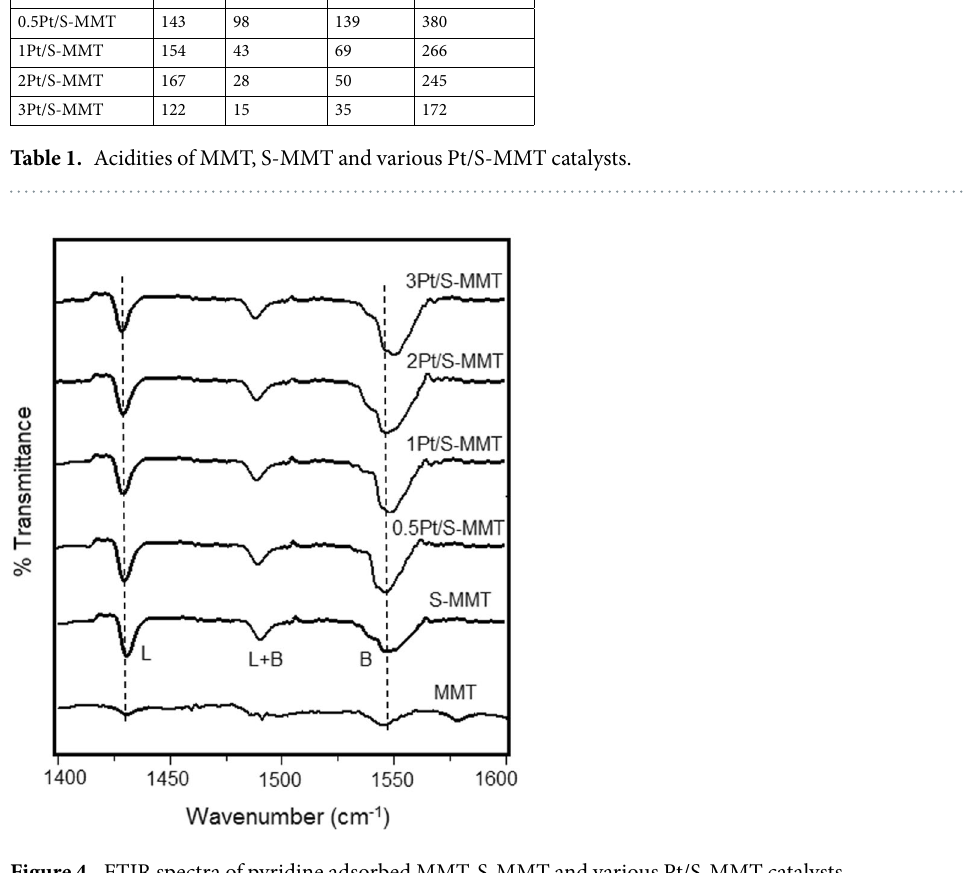
Figure 4. FTIR spectra of pyridine adsorbed MMT, S-MMT and various Pt/S-MMT catalysts.